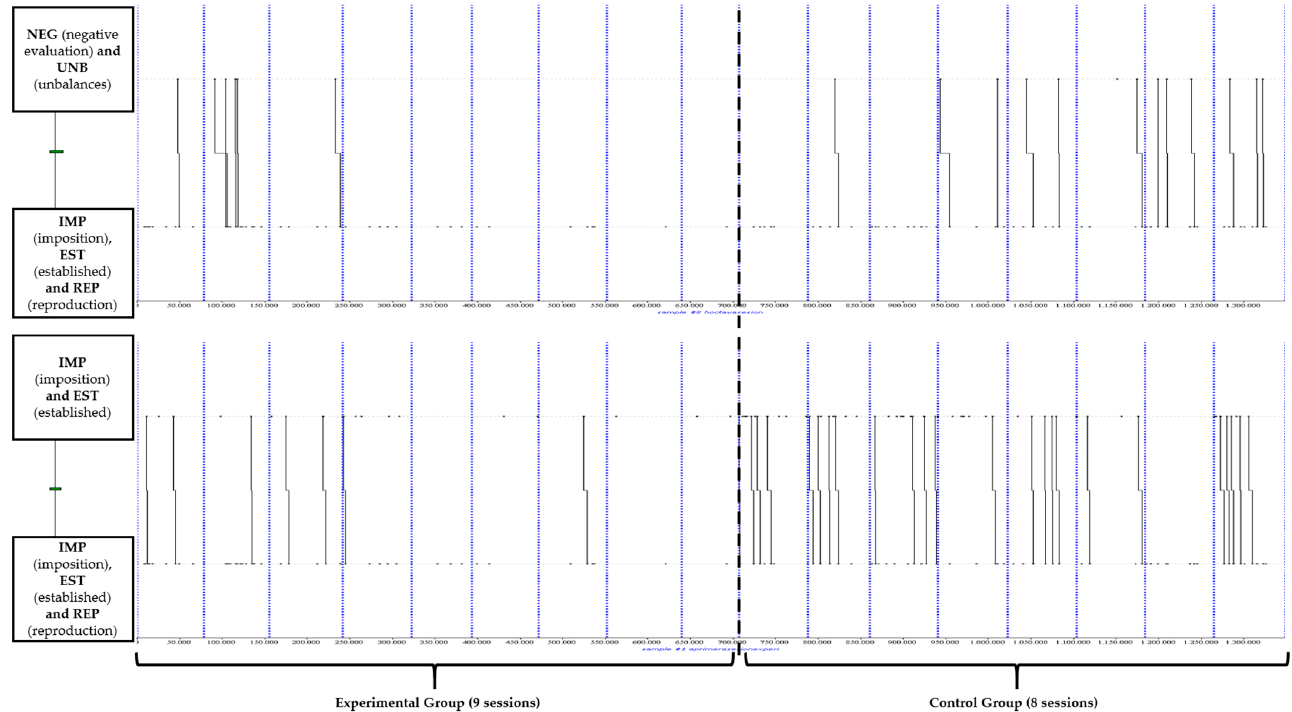
Figure 4. Dendogram representing the comparison of temporal patterns of teachers (EG and CG) associated with traditional teaching behaviours (direct command), and student responses.